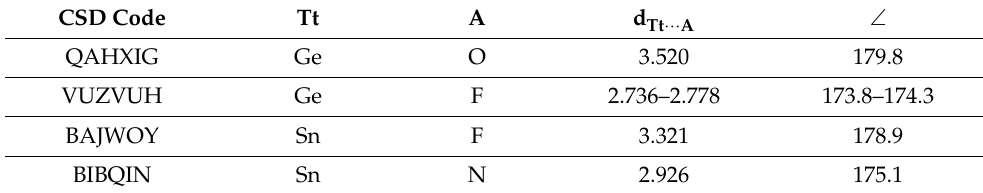
Table 2. CSD codes, TtB donor (Tt), and acceptor (A) atoms, intermolecular distance (d Tt ··· A in Å), and X–Tt ··· A (X = C, O, F and Cl) angle ( ∠ in ◦